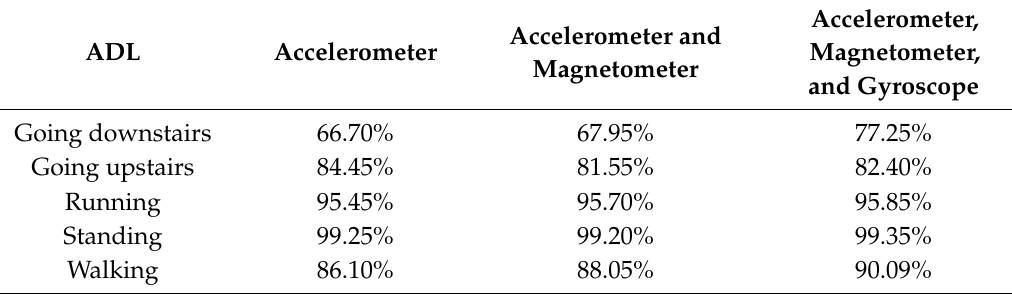
Table 7. Accuracies of ADL identification using the DNN